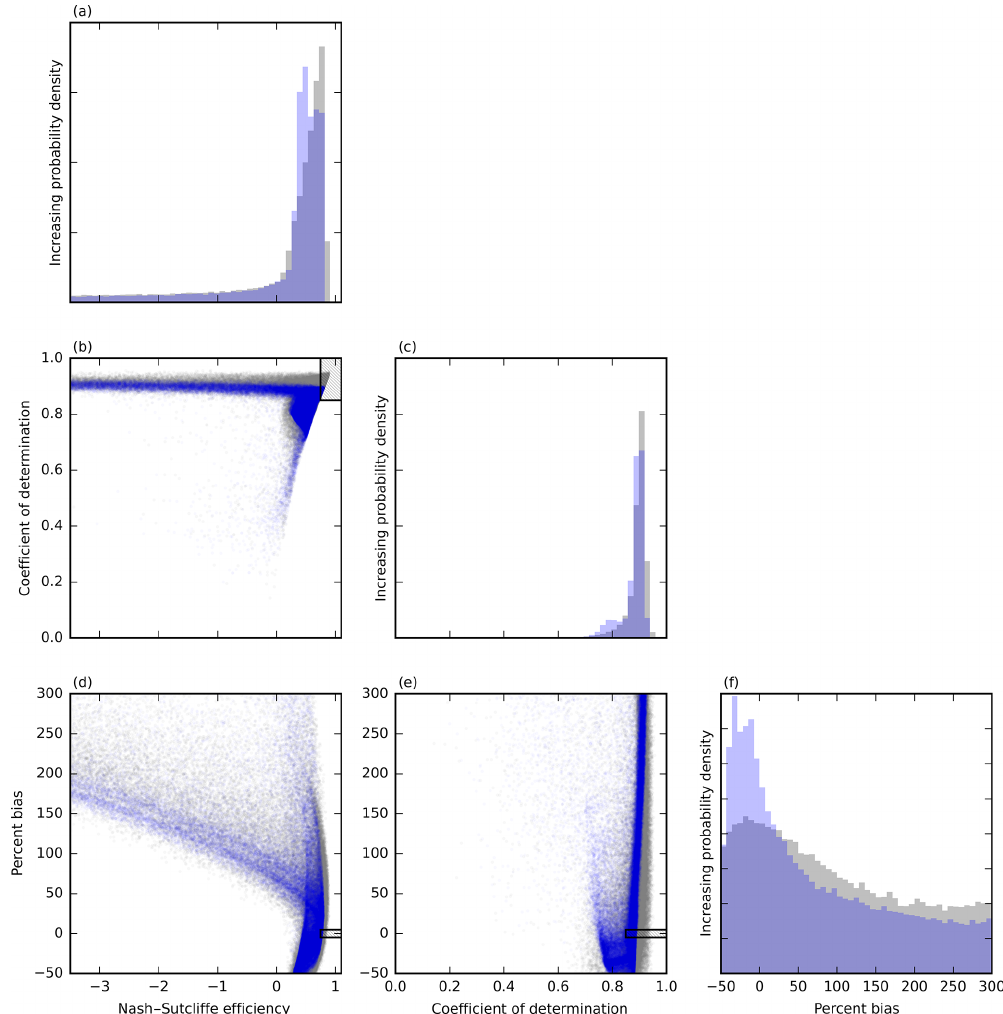
Figure 3. Values of conditioning measures for the full (gray) and reduced (blue) parameterizations. The diagonal panes (a, c, f) show distribution of each conditioning measure; the off-diagonal panes (b, d, e) show the relation between respective conditioning measures. The hatched boxes mark the 3-dimensional behavioral region; realizations within the hatched boxes comprise the behavioral ensembles of each